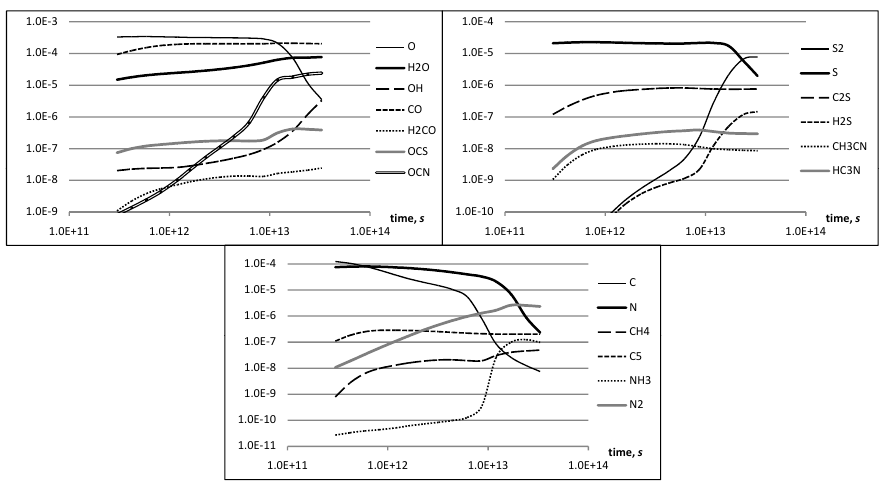
Fig. 4. Calculated total (solid + gas phase) relative abundances for selected species for Model 2 (with freeze processes). Pay attention to the relative abundance (ordinate) scale for each